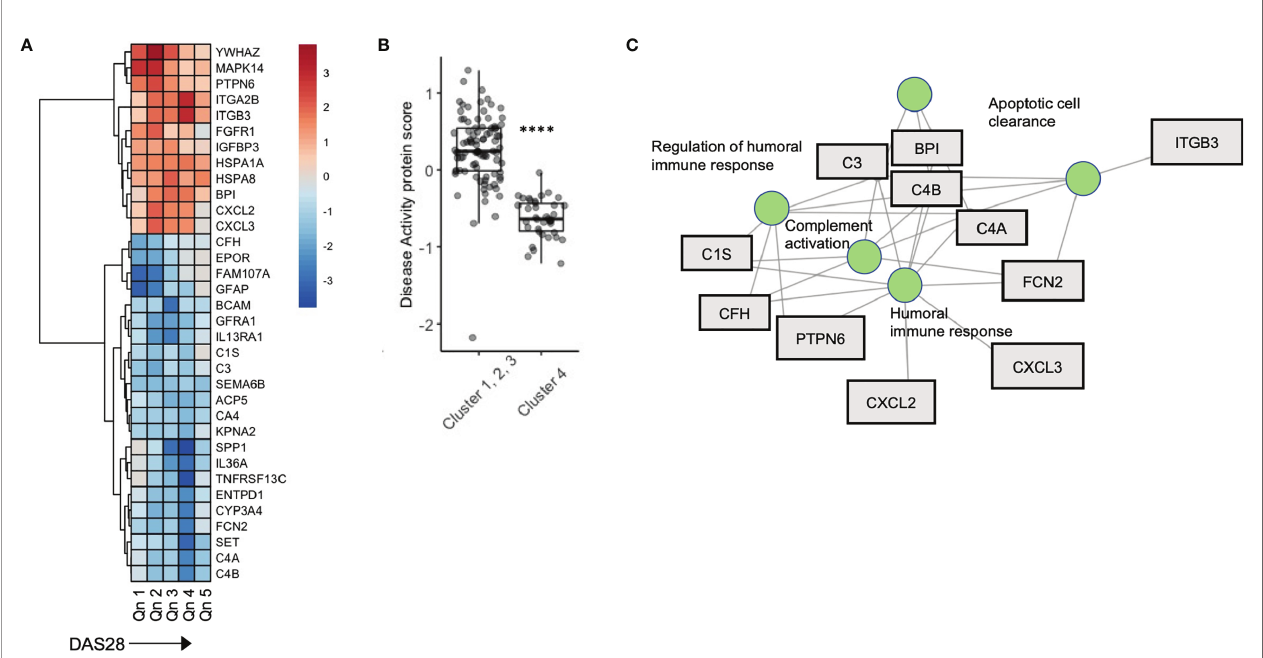
FIGURE 4 | A serum proteomic signature is associated with DAS28 in stable RA. (A) Sliding window analysis of disease activity (Quintiles x-axis) and 34 proteins that vary with DAS score after controlling for Age and Sex . Heatmap is colored on coef fi cient relationship to DAS score (B) Box plots of disease activity protein score split by cluster assignment. (C) Gene concept plots derived from disease activity protein score. Each node represents a GO pathway with proteins connected by edges. ITGA2B, Integrin alpha 2B; BPI, Bactericidal permeability-increasing protein; CXCL2, Chemokine ligand 2; C3, Complement C3; C4A, Complement 4A; C1S, Complement 1S. ****p <